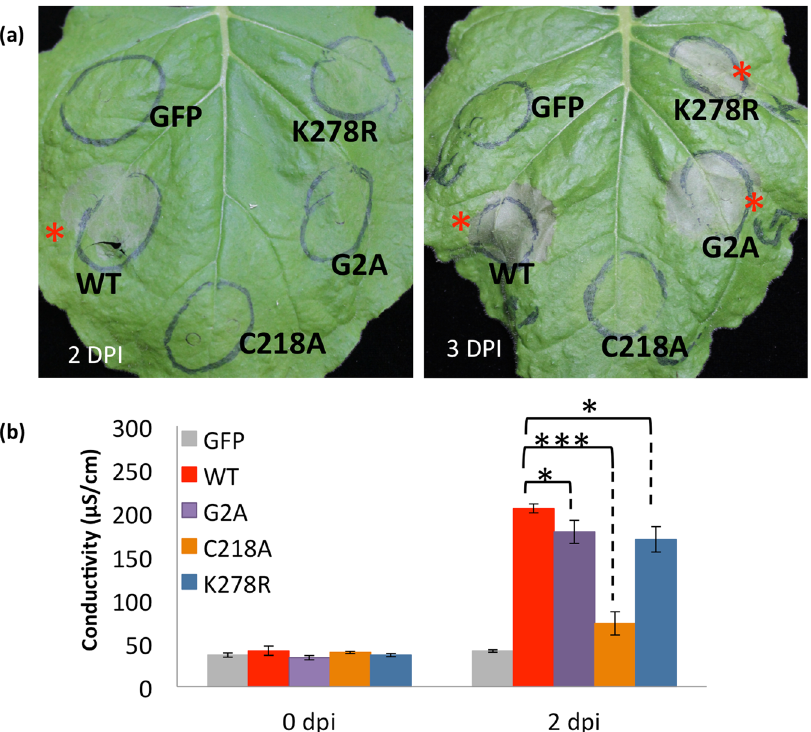
Figure 5. HopZ5 recognition in Nicotiana benthamiana requires acetyltransferase activity. ( a ) HopZ5 (WT) or mutated myristoylation (G2A), catalytic core (C218A) and autoacetylation-required (K278R) variants tagged with 3xFLAG were transiently expressed under the CaMV 35 S promoter in N . benthamiana Photographs were taken at 2 or 3 days post infiltration (dpi). Red asterisks indicate development of hypersensitive response-like cell death symptoms. This experiment was conducted six times with identical results. ( b ) Electrolyte leakage from N . benthamiana leaf discs triggered by Agrobacterium -mediated transient expression of HopZ5 or variants, as in ( a ), was determined at 0 and 2 days post infiltration (dpi). Infiltrations were carried out by blunt syringe at OD 600 = 0.4 for all samples. Error bars represent standard error from four technical replicates. Asterisks indicate results of Student’s t -test between selected samples; * ( P < 0.05), *** ( P < 0.001). This experiment was conducted three times with identical